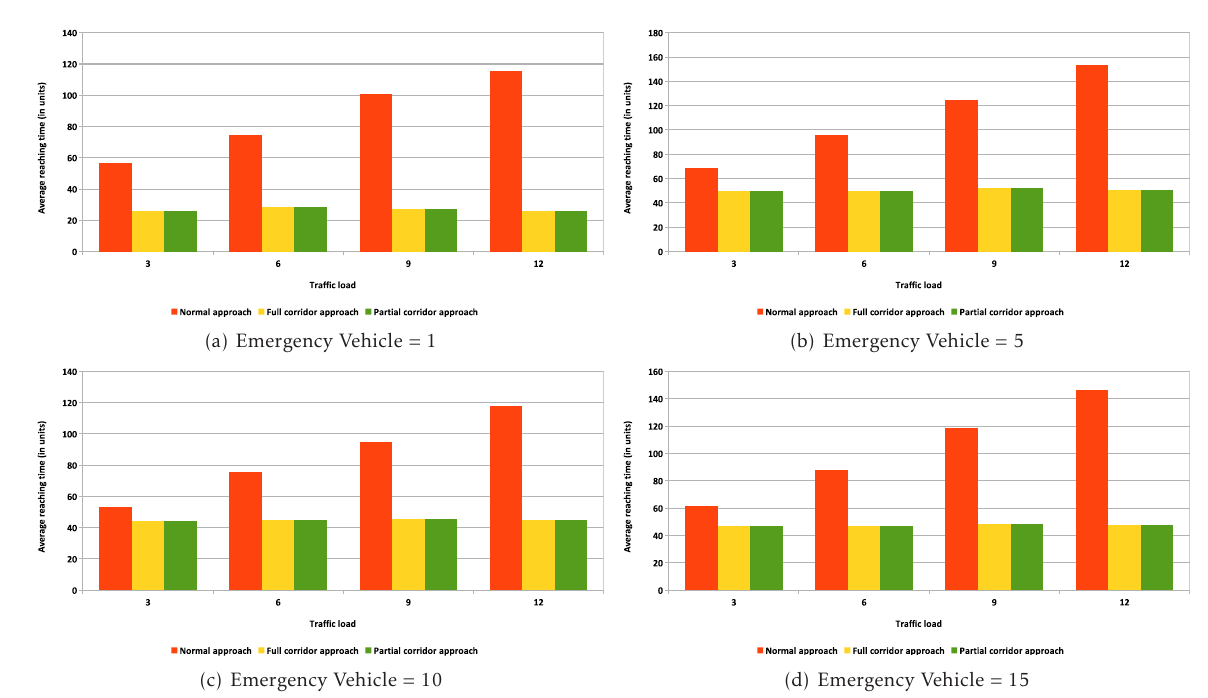
Figure 3. The average reaching time for varying number of emergency vehicles under different traffic loads in case of Normal , Full Corridor and the proposed Partial Corridor based approaches